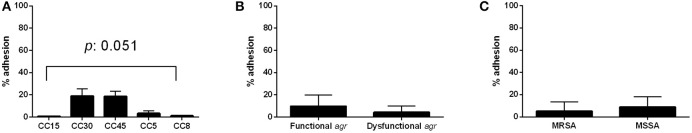
Adherence to collagen. Adhesion percentage to collagen according to CC (A), agr functionality (B), and methicillin resistance (C). Bars and error bars represent the mean and standard deviation of at least 3 independent experiments. Only significant p-values are shown.